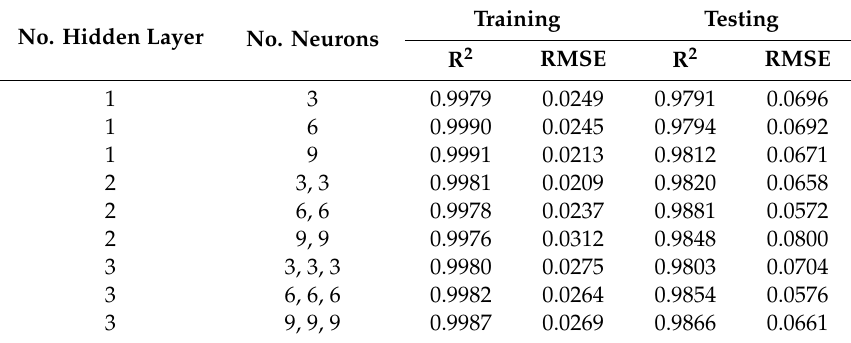
Table 8. Statistical results of drying kinetics of persimmon fruit samples for the artificial neural network (ANN) model using VD.